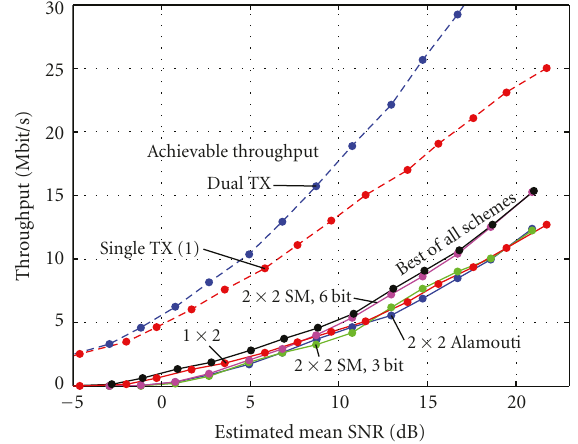
Figure 7: Scenario 1, measured (solid) and achievable (dashed) data throughput in the NLOS outdoor-to-indoor scenario using two receive